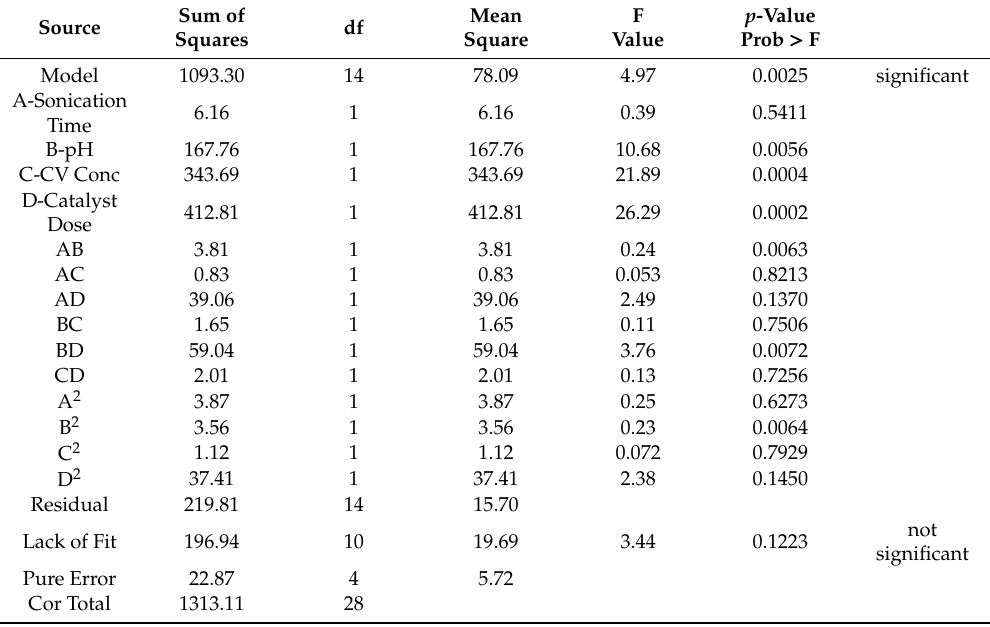
Table 1. Analysis of variance (ANOVA) for the adsorption of crystal violet (CV) on